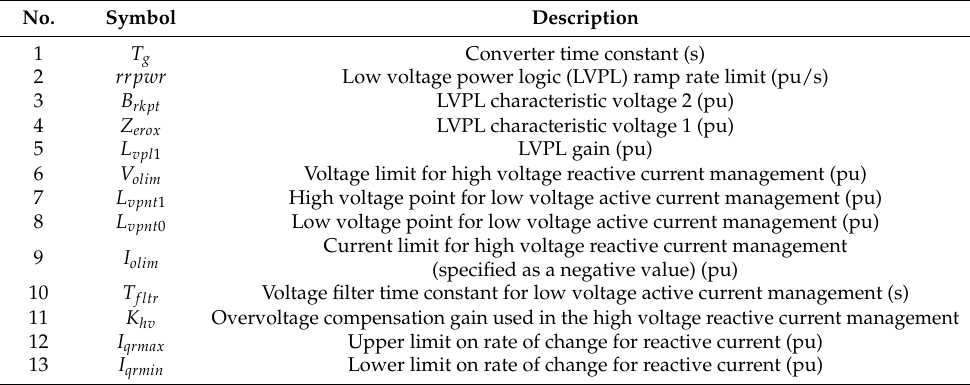
Figure 4. The REGC module control block diagram of a universal model of energy storage systems. Reprinted from Ref. [4] (Fig. 12), 2016, Xiaokang Xu. Table 3. Parameters of the REGC module.